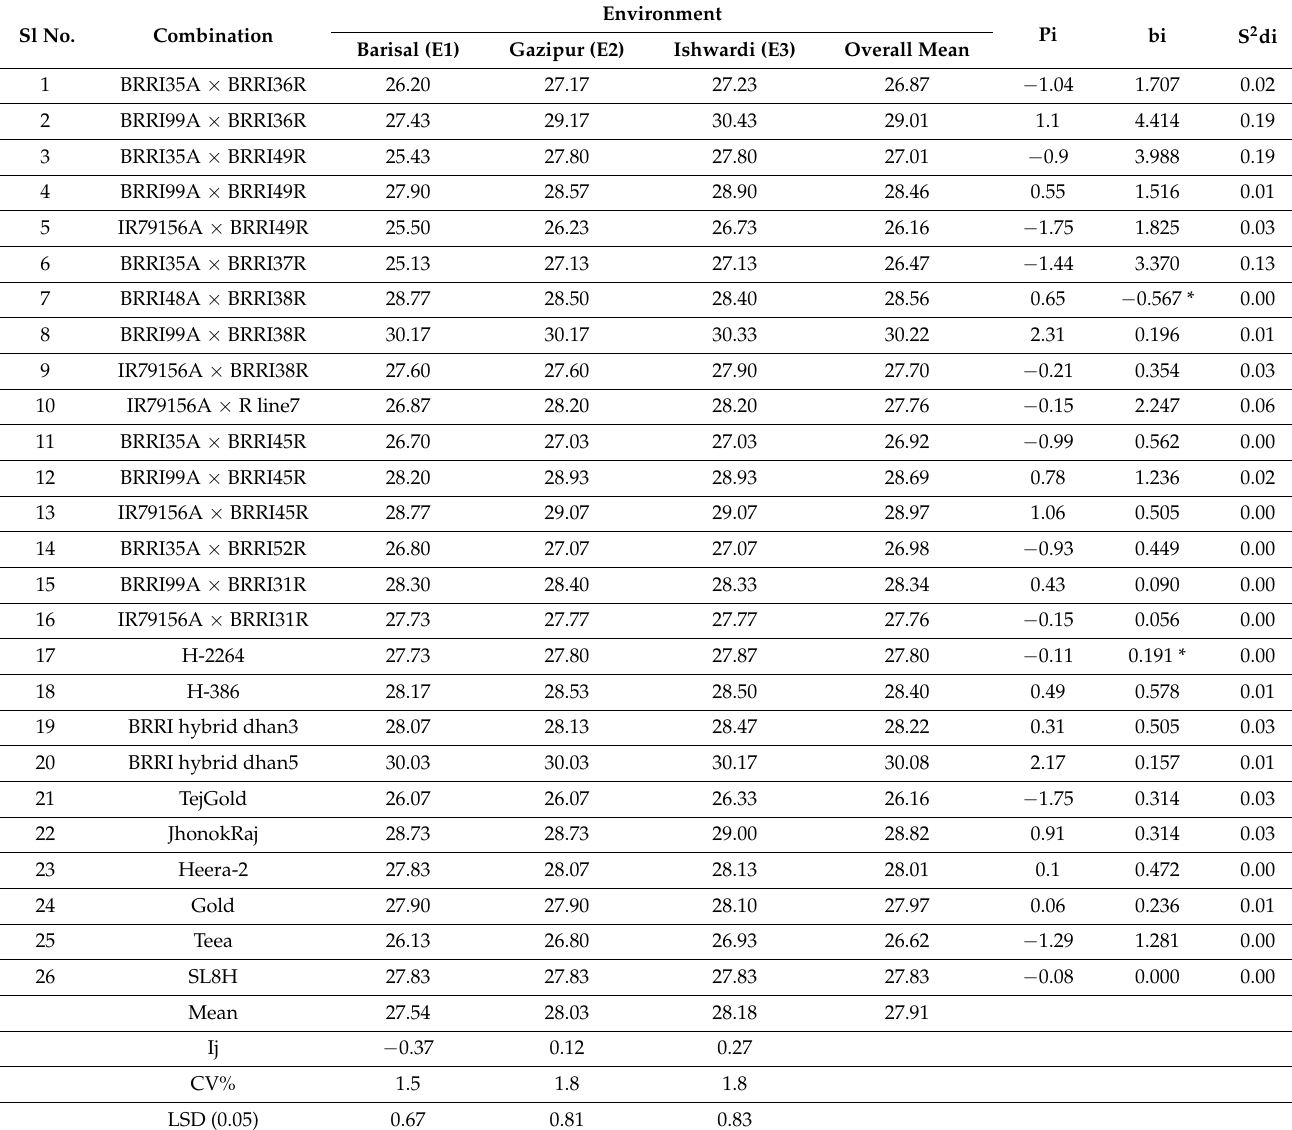
Table 8. Stability analysis for panicle length of 26 hybrid combinations at three